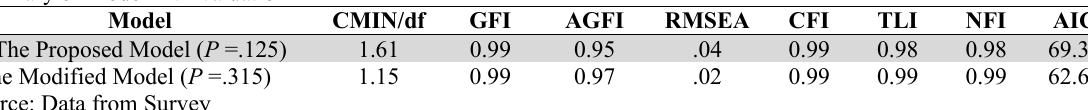
Summary of Model Fit Evaluation